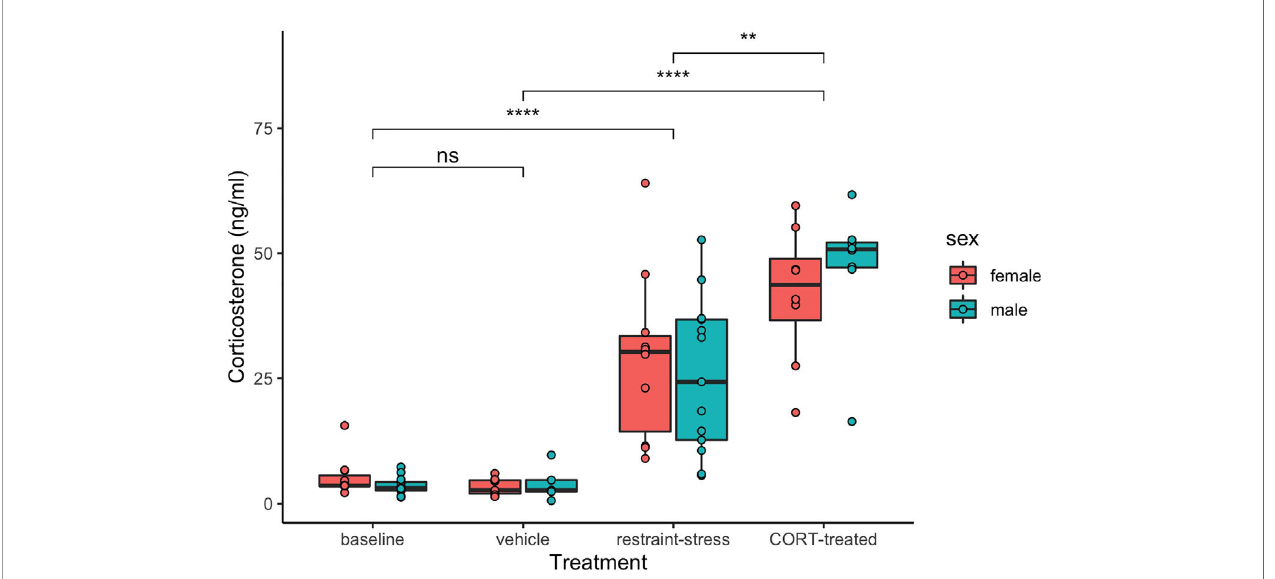
FIGURE 1 | Circulating corticosterone (ng/mL) of male (aqua) and female (pink) C. livia of restraint-stress (baseline control and restraint-stress, left panel) compared to the exogenous treatment (vehicle and CORT-treated, right panel). Boxes include medians and interquartile range while whiskers indicate variability outside the quartile range. Statistically signi fi cant differences between treatments are indicated by brackets and ‘ ns ’ = p > 0.05, ‘ ** ’ = p < 0.01, ‘ **** ’ = p <